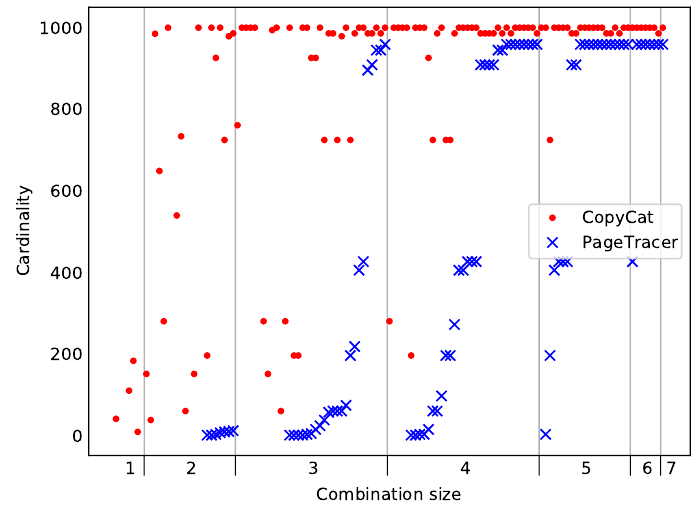
Figure 5: wolfSSL cardinality vs. combination